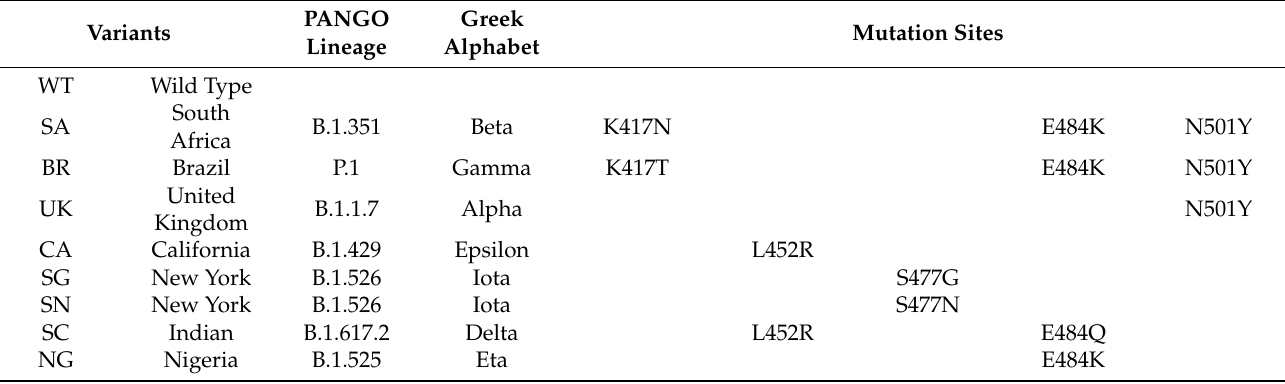
Table 1. Mutation sites in the